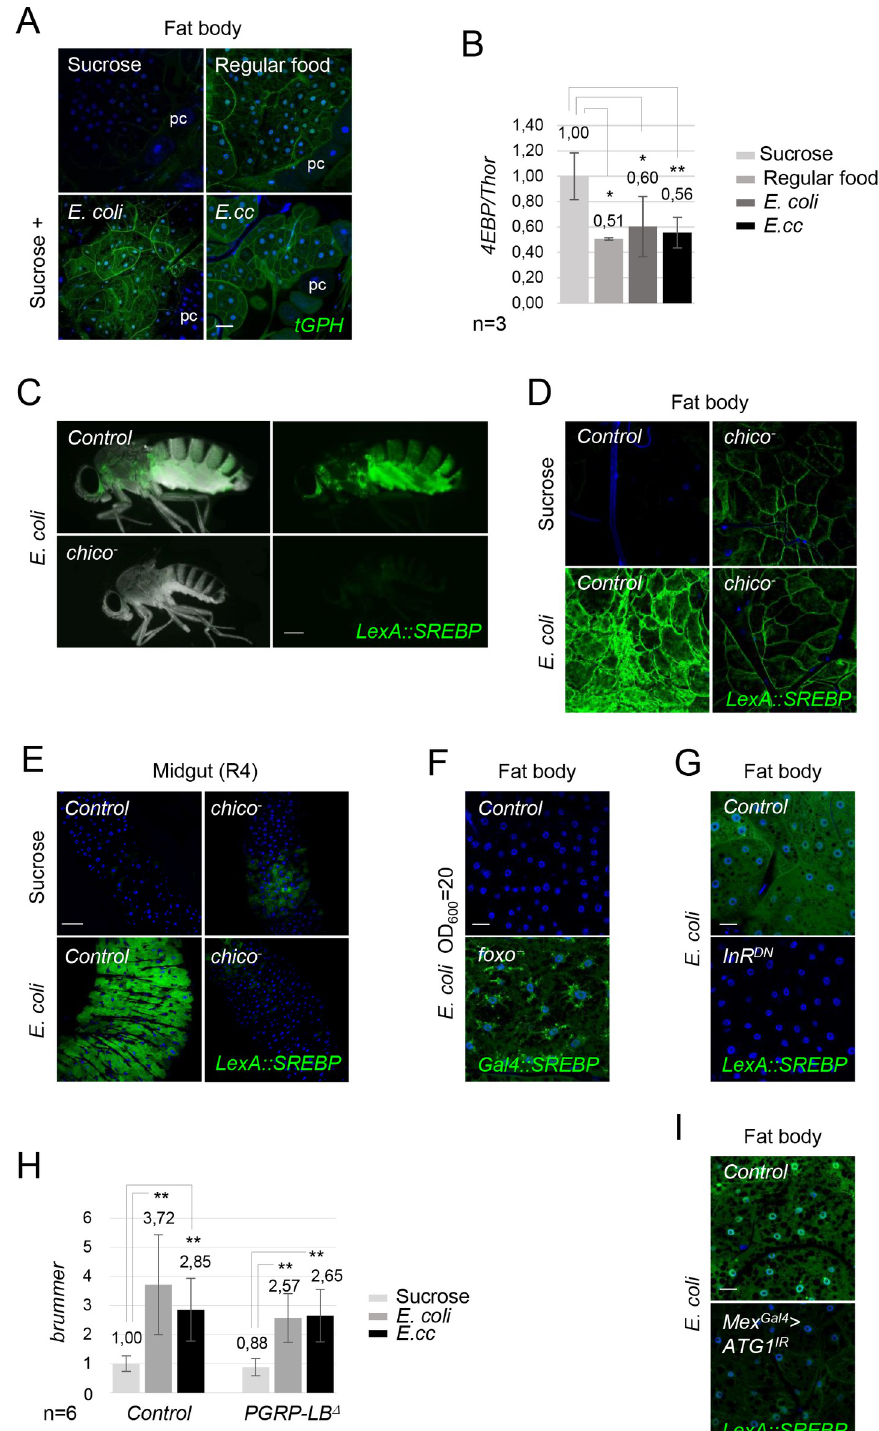
Fig 3. E . coli and E . cc ingestion promotes systemic insulin signaling pathway and insulin signaling is required for SREBP activation by E . coli . (A) Confocal images of fat body from flies fed 4 days with either sucrose, regular food or a mixture of sucrose + E . coli or E . cc . The expression of the tGPH marker is shown in green. An intense recruitment of tGPH at the cell surface of adipocytes is observed in flies fed on regular food or orally infected with either E . coli or E . cc , when compared to a sucrose diet. Flies of the following genotypes were used: w 1118 / w 1118 ; tGPH/tGPH . pc: